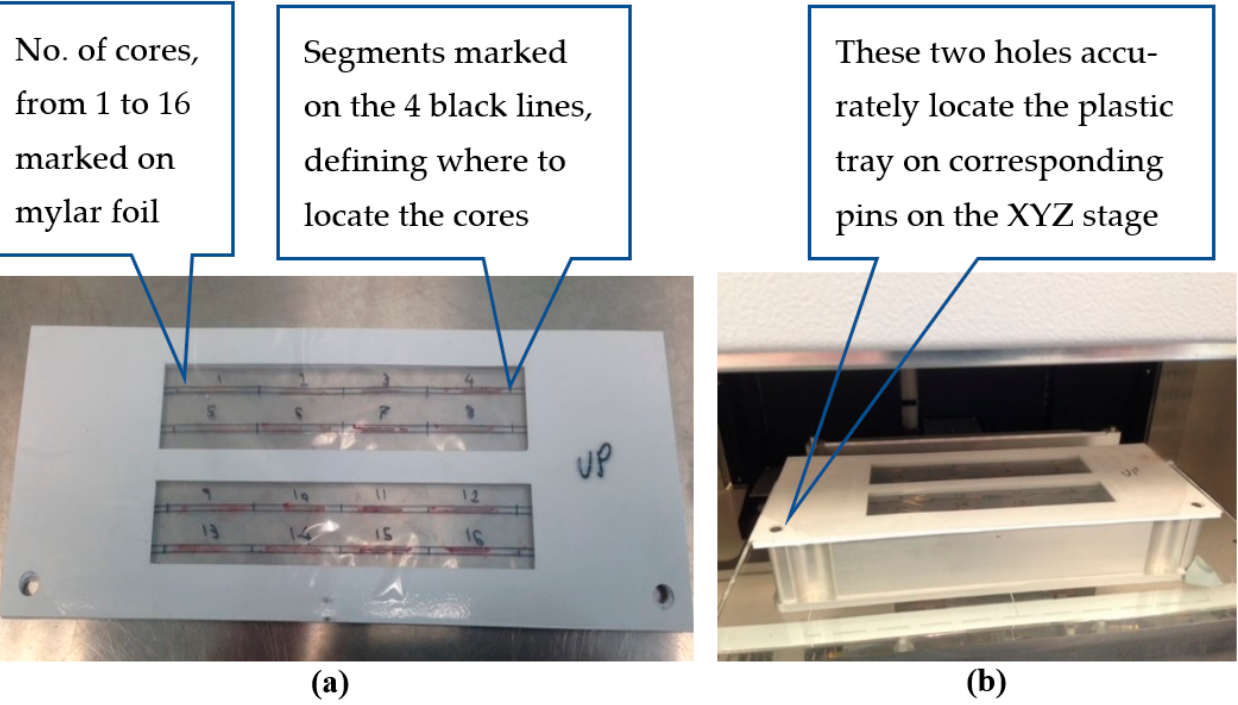
Figure 2. Samples tray and tray holder in the Bruker XRF device. ( a ) Low-background plastic tray; ( b ) Tray holder located on the XYZ stage, with plastic tray on